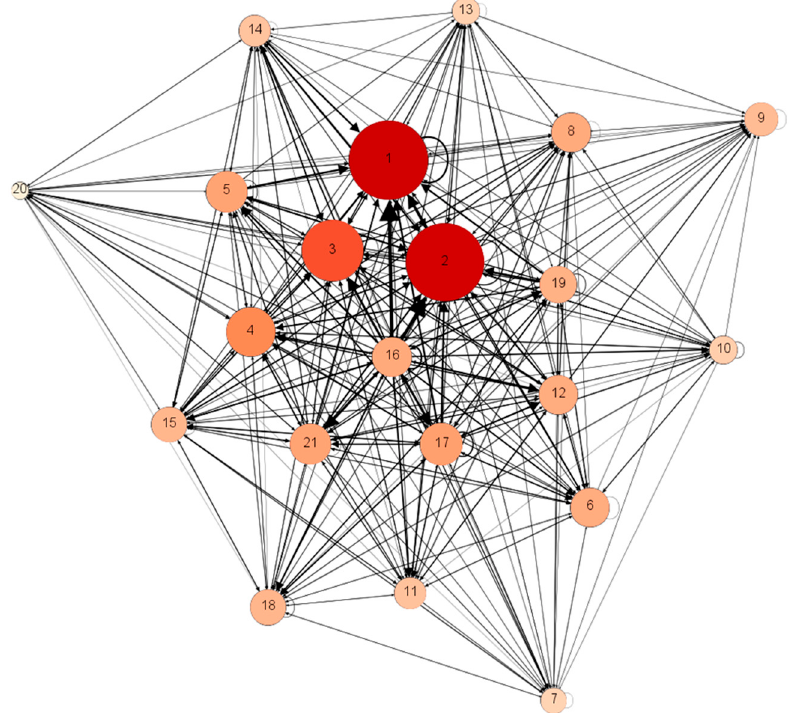
Figure 3. Social network of DT in the olive landscape in Andalusia—Actors receiving knowledge. The size and colour of the nodes indicate the degree of input, the larger and darker the node, the greater the degree of information reception.